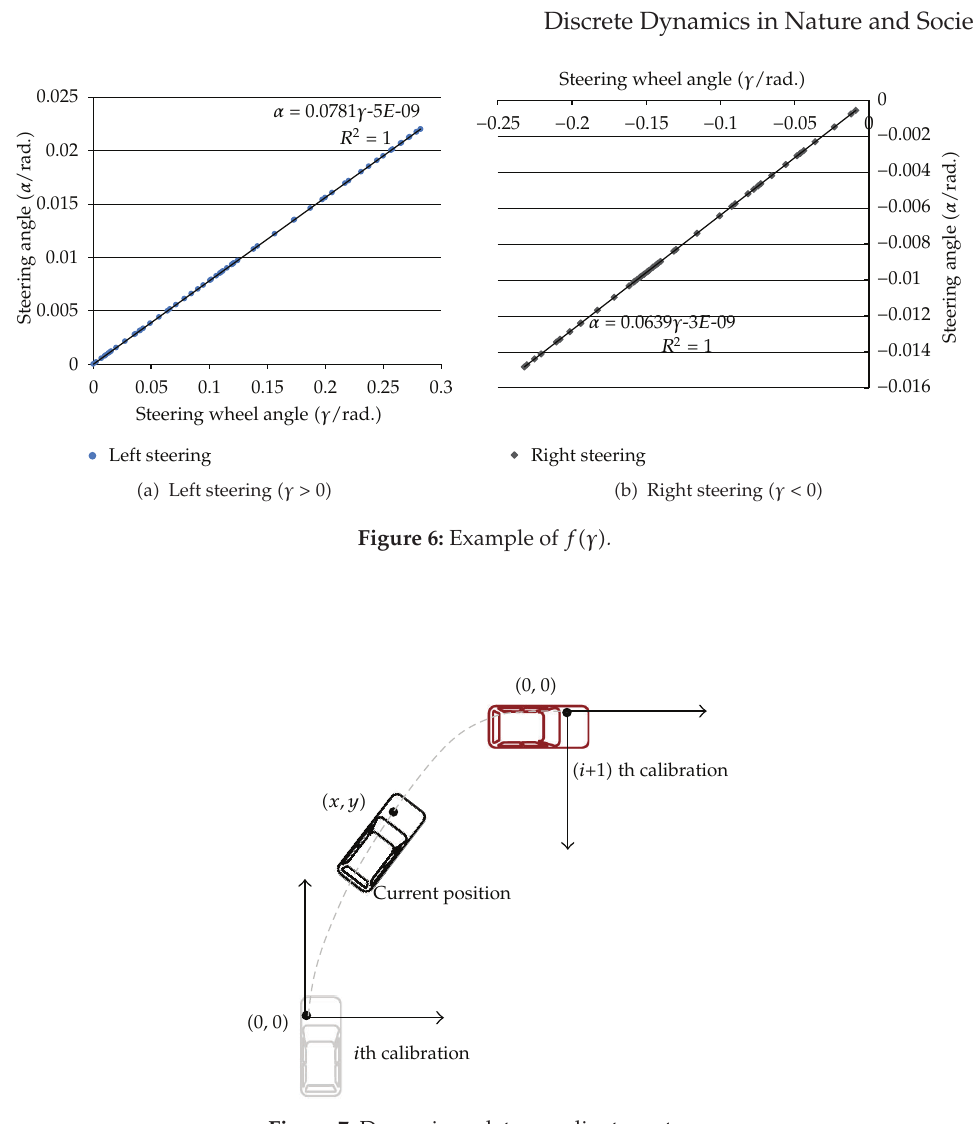
Figure 7: Dynamic update coordinate